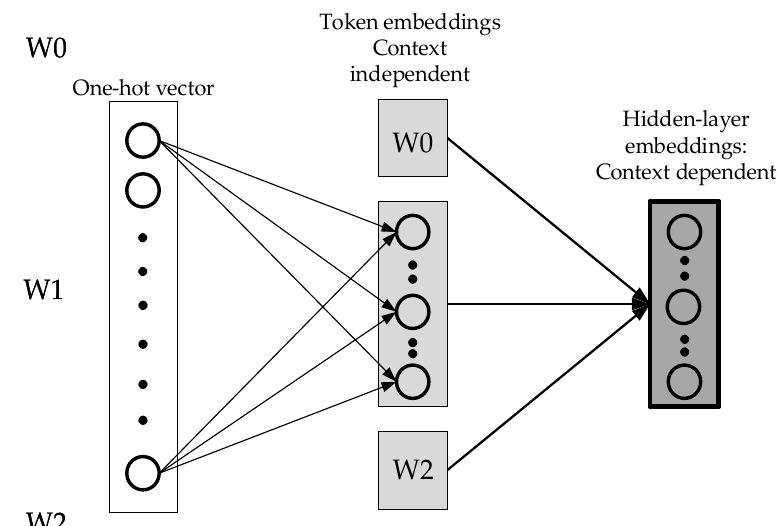
Figure 2. One-hot vector input of BERT.